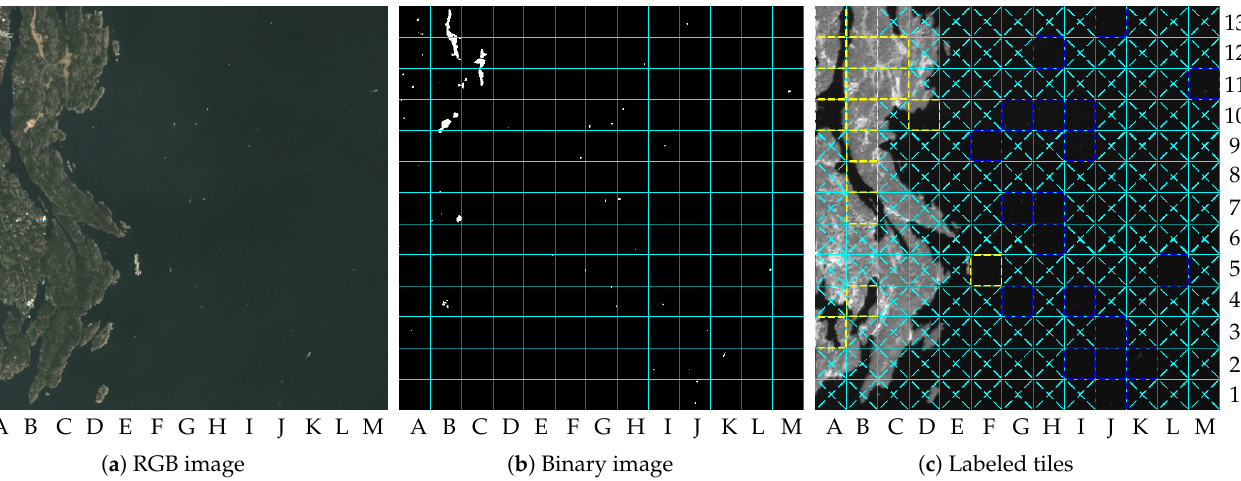
Figure 10. Results for image 5: ( a ) RGB image (truncated at 2000); ( b ) binary image; ( c ) labeled tiles (truncated at 4000).